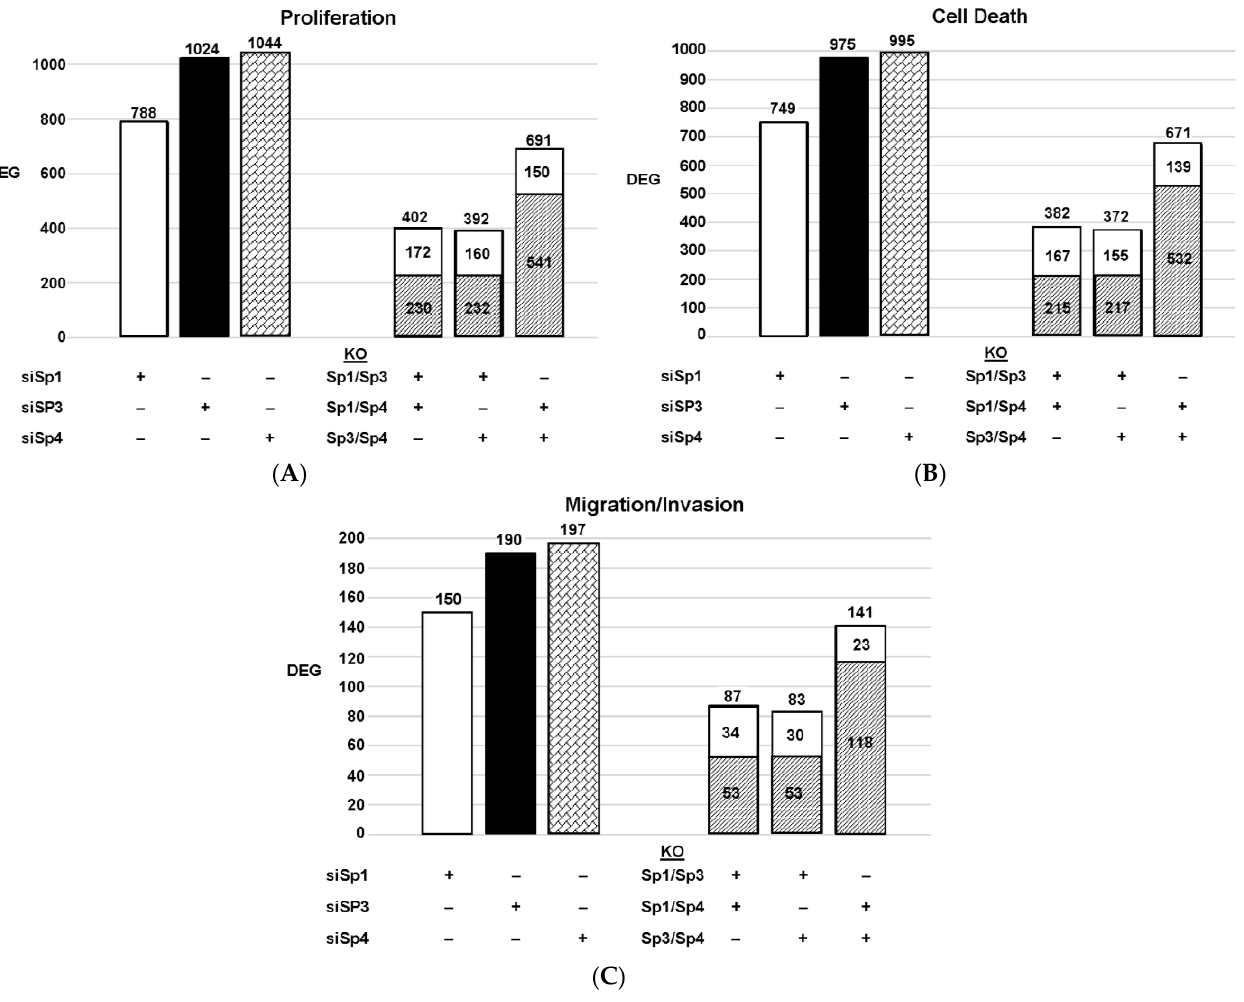
Figure 3. Effects of Sp knockdown by RNAi [7]: IPA analysis of the differentially expressed genes in Panc1 cells associated with cell proliferation ( A ), Annexin V staining ( B ), and invasion ( C ). In these same samples, the common genes observed after knockdown of Sp1/Sp3, Sp1/Sp4 and Sp3/Sp4 are given. (